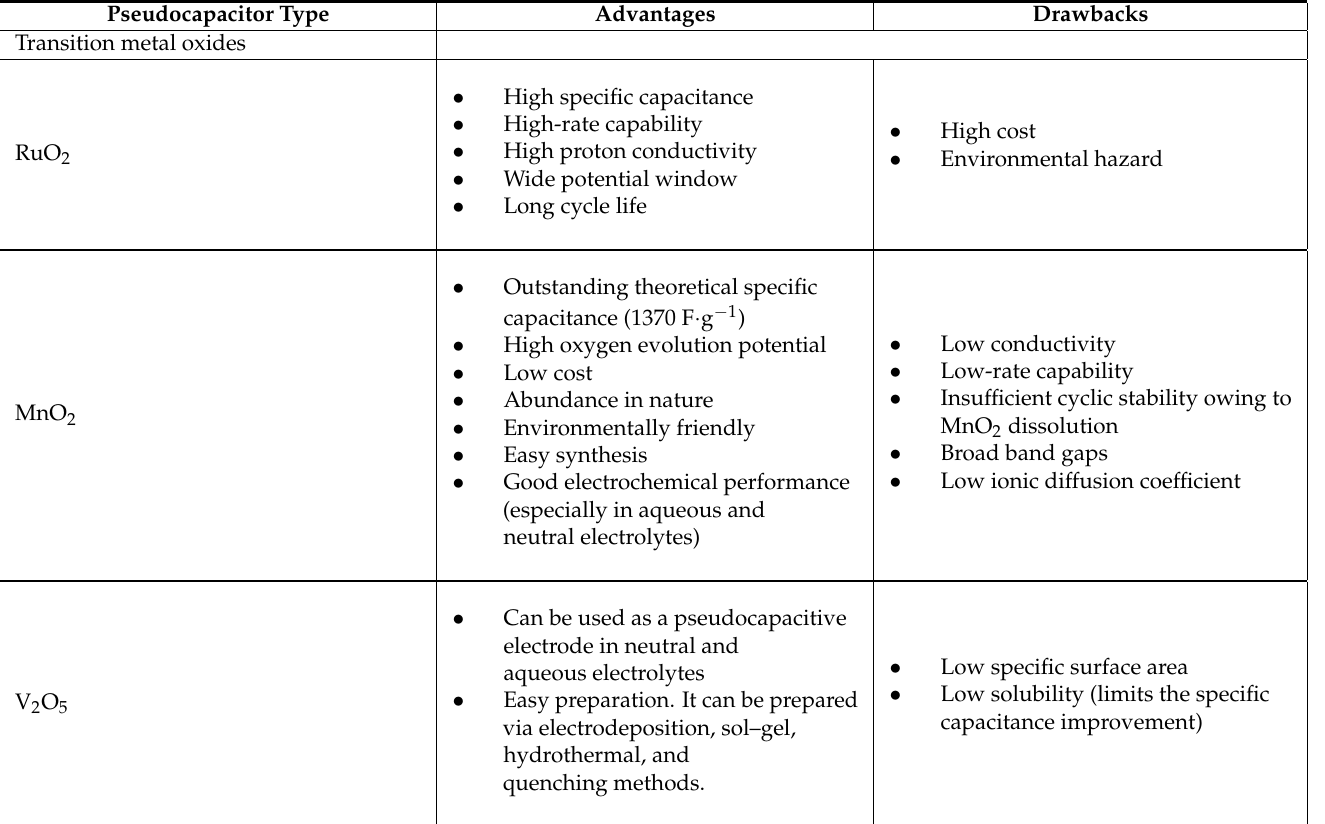
Table 1. Comparison of different pseudocapacitor material